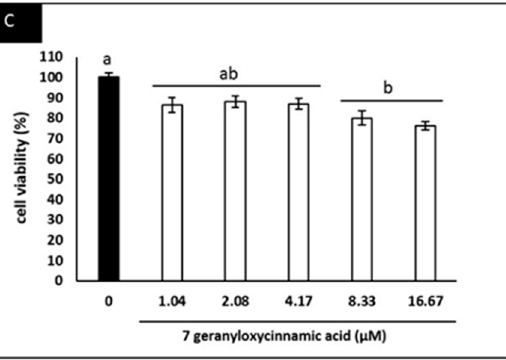
Figure 3. Cytotoxicity of 7-geranyloxycinnamic acid in di ff erentiated SH-SY5Y cells at various concentrations (1.04–16.67 µ M). ( A ) 24 h incubation; ( B ) 48 h incubation; ( C ) 72 h incubation. Data